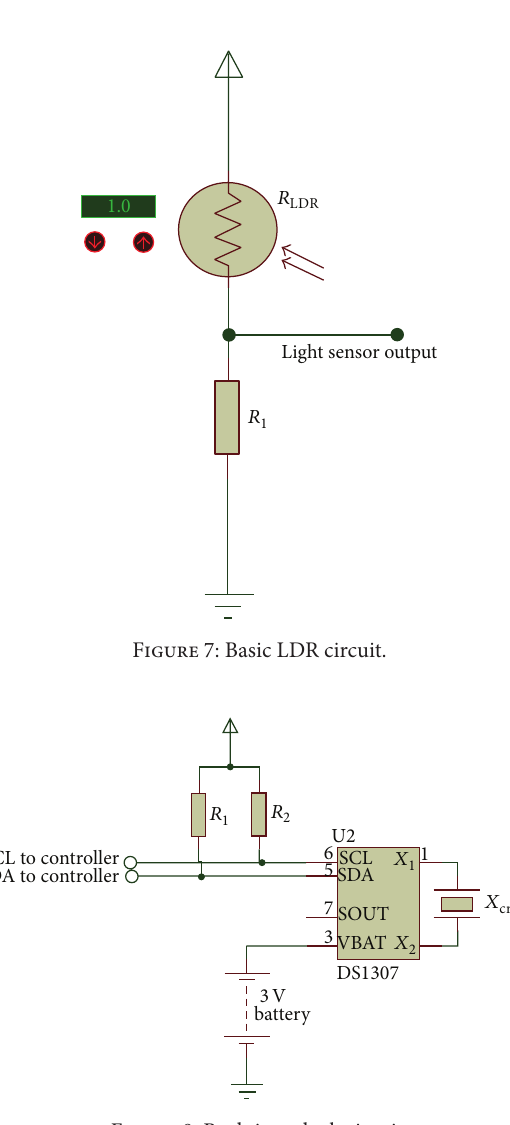
Figure 8: Real time clock